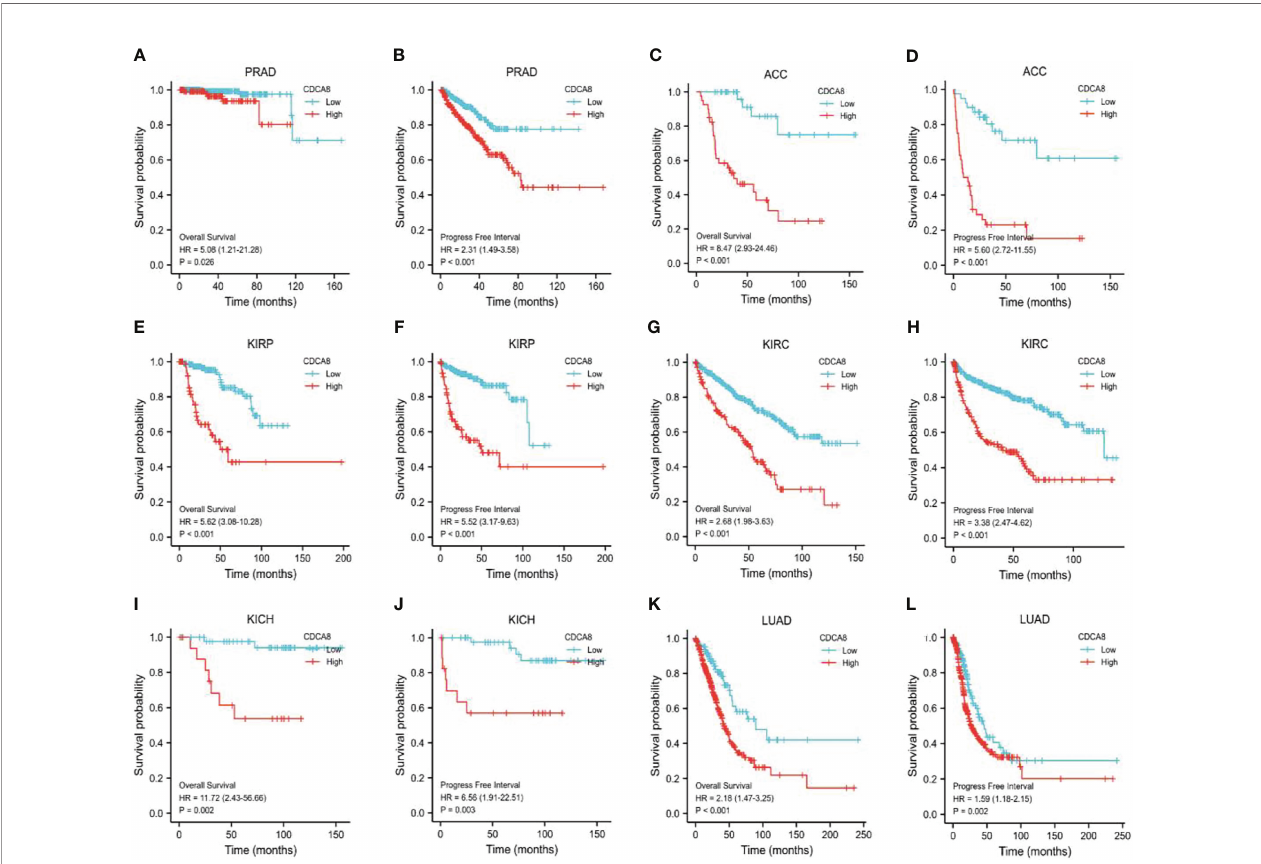
FIGURE 5 | Survival analysis of CDCA8-Associated Cancers. OS and DFS in patients with PCa (A, B) , ACC (C, D) , KIRP (E, F) , KIRC (G, H) , KICH (I, J) , and LUAD (K, L)